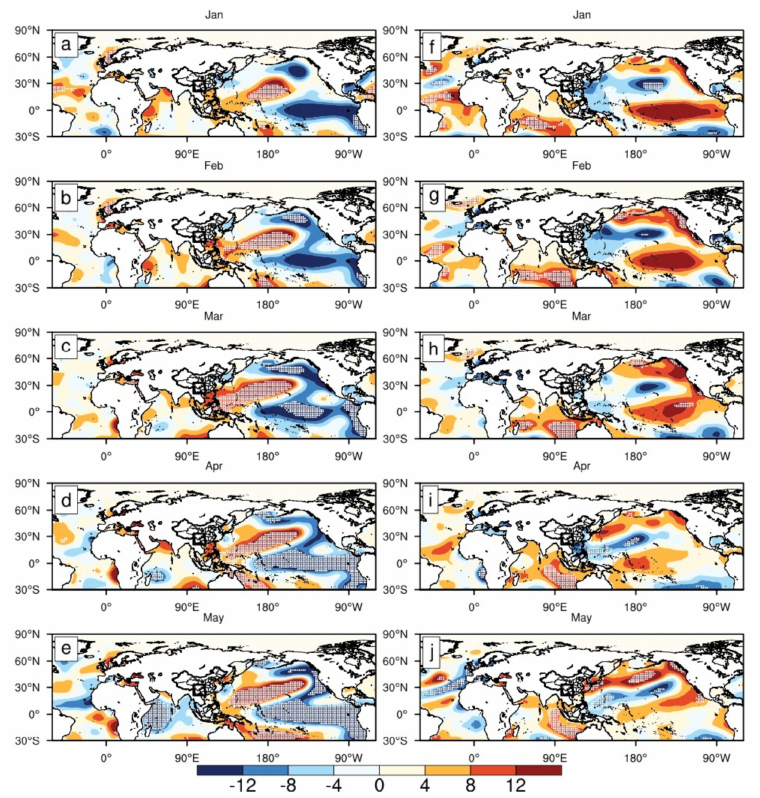
Figure 7. ( a – e ) Regressed anomalies of the interannual components of SST from January to May (shaded, unit: 10 − 2 ◦ C) onto the interannual components of PC1 for the period of 1960 to 2018. ( f – j ) As in ( a – e ), but for PC2. The white spots denote the values that have passed the 95% confidence level; the black squares represent the Southwest China (21 ◦ –33 ◦ N, 97 ◦ –110 ◦